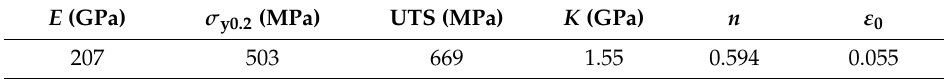
Table 1. Mechanical properties from tensile tests and Swift’s power law